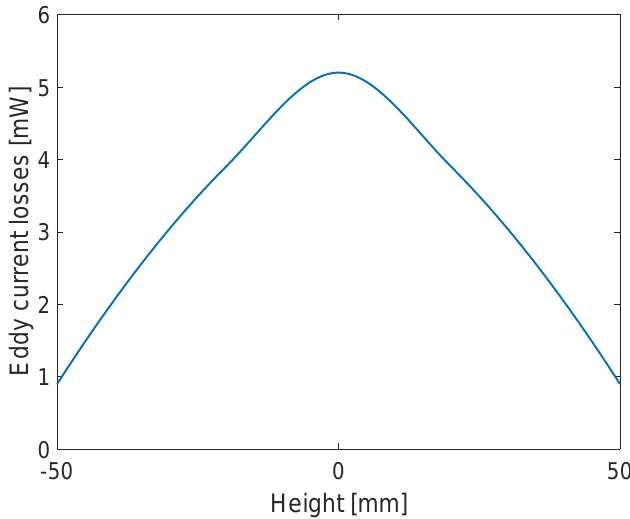
Figure 8. Eddy current losses dependence on